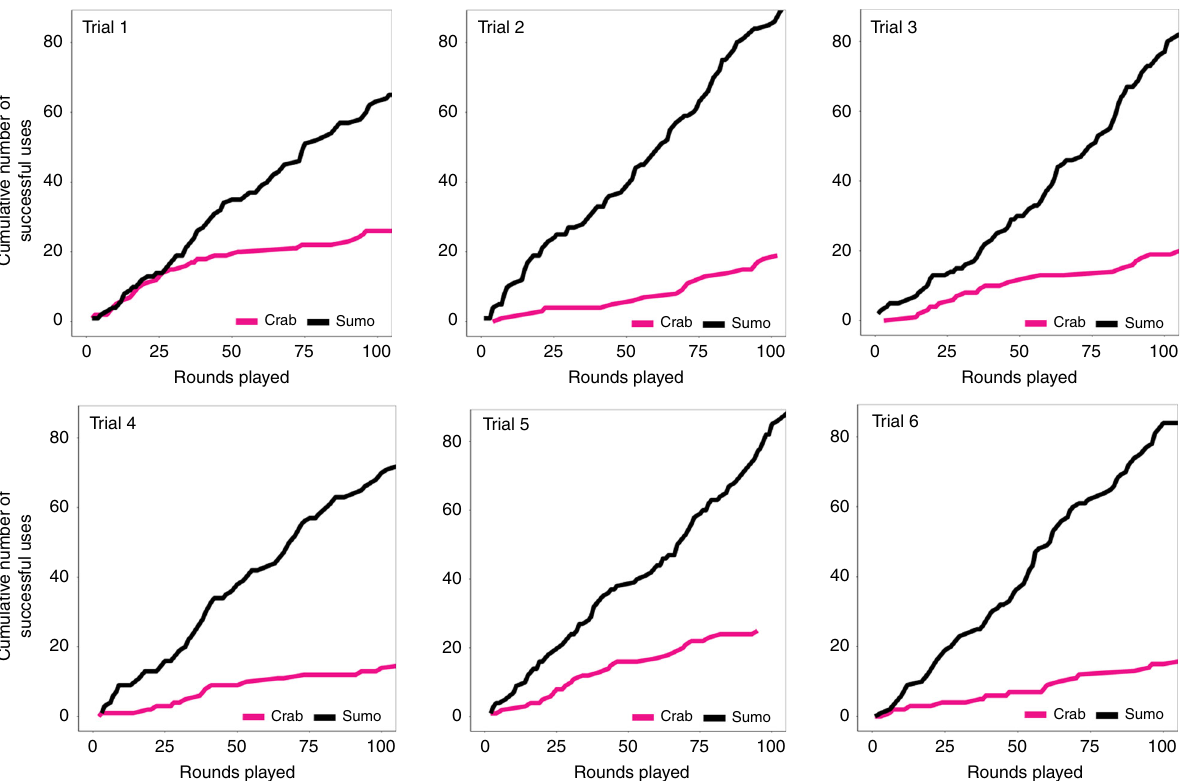
Fig. 4 Time series showing the adoption of the confederates ’ rare label ( “ sumo ” ) by experimental subjects (i.e., nonconfederate subjects). Pink lines indicate the cumulative number of successful uses among experimental subjects of the label “ crab ” . Black lines indicate the cumulative number of successful uses among experimental subjects of the label “ sumo ” . Each round is measured as N /2 pairwise interactions, such that each player has one interaction per round. The data displayed exclude all interactions between ( N = 1), which generated results consistent with our fi ndings for dyads (Figs. S2 and S3). We collected 80 dyads ( N = 2) and 15 social networks for each population size (i.e., N = 6, N = 8, N = 24, and N = 50). There were no differences in the distribution of demographic traits across conditions, in terms of gender ( p = 0.56),